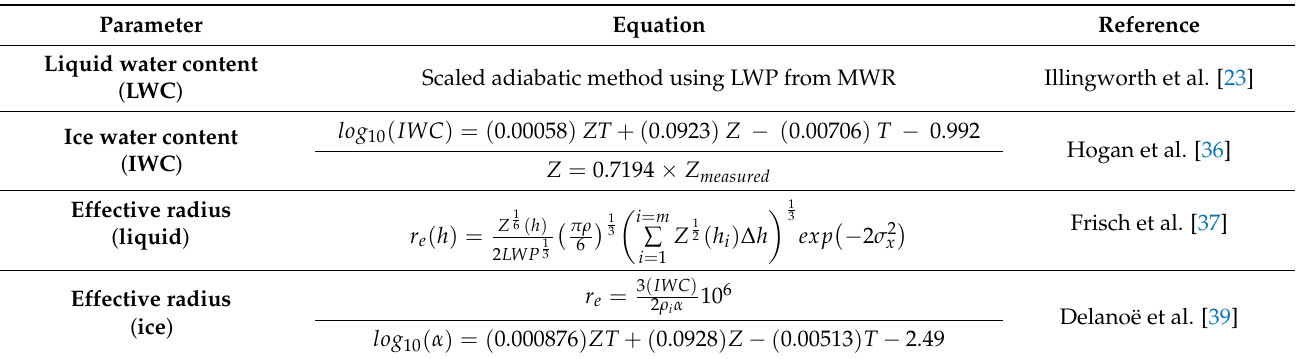
Table 1. Retrieval methods of cloud microphysical